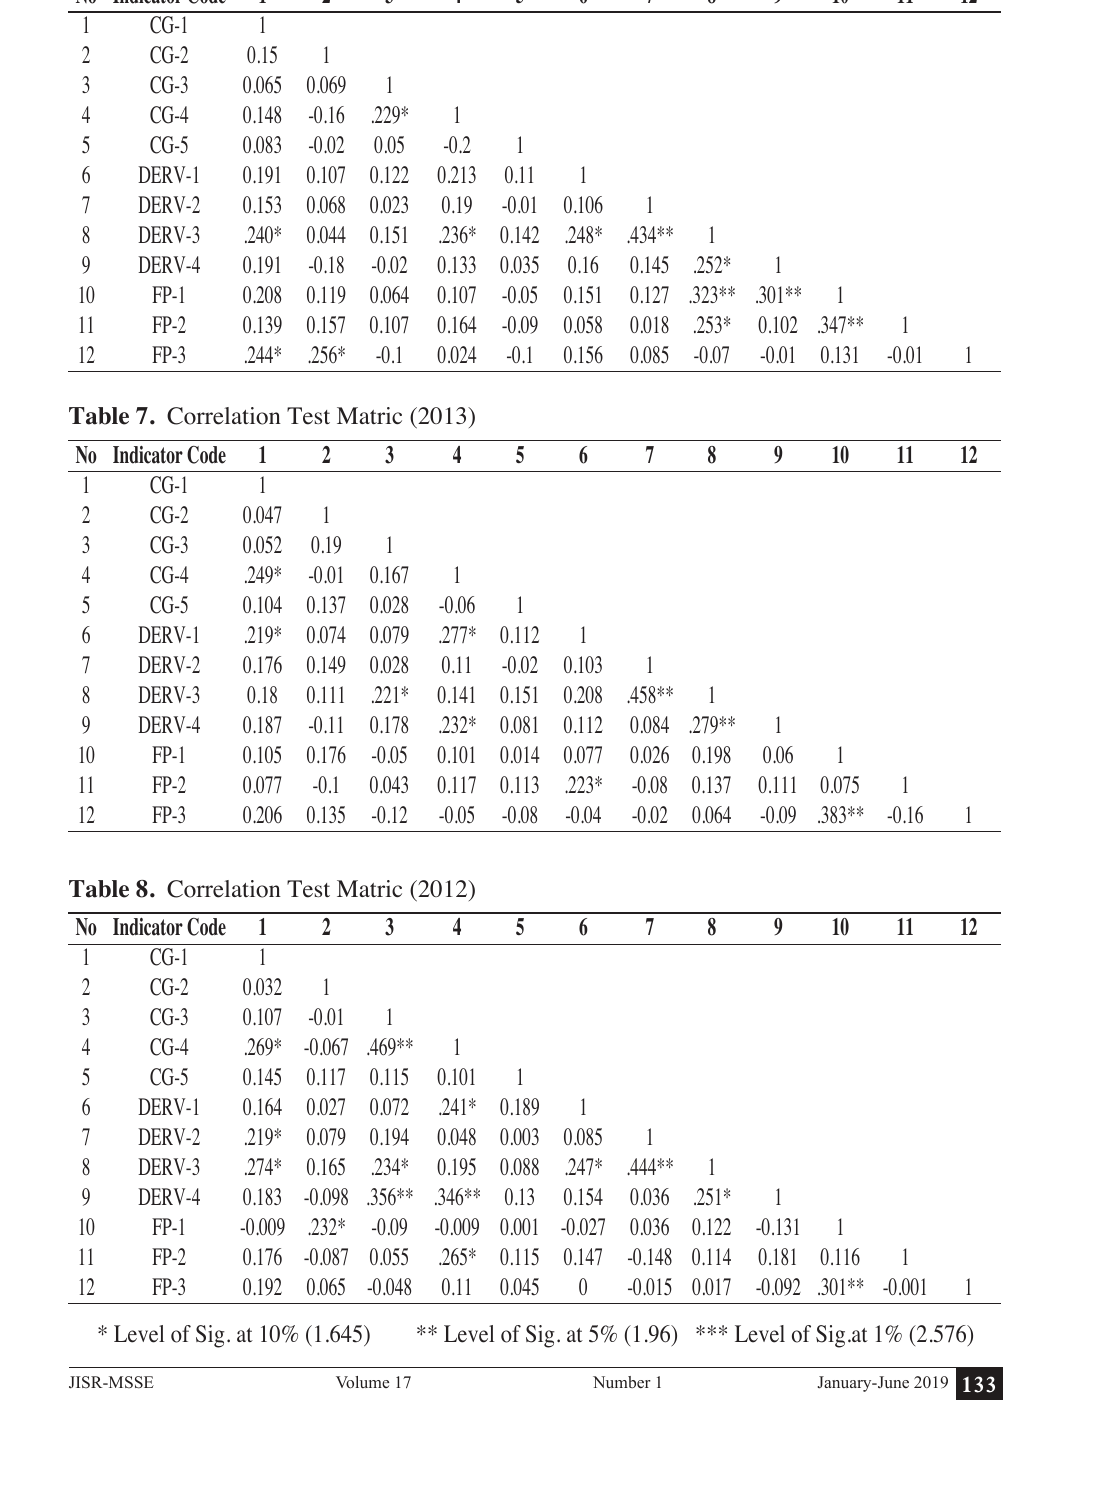
Table 6. Correlation Test Matric (2014)